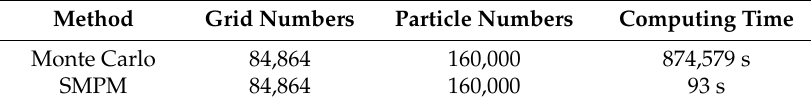
Table 9. Computing time of the methods (example 2, C.V =